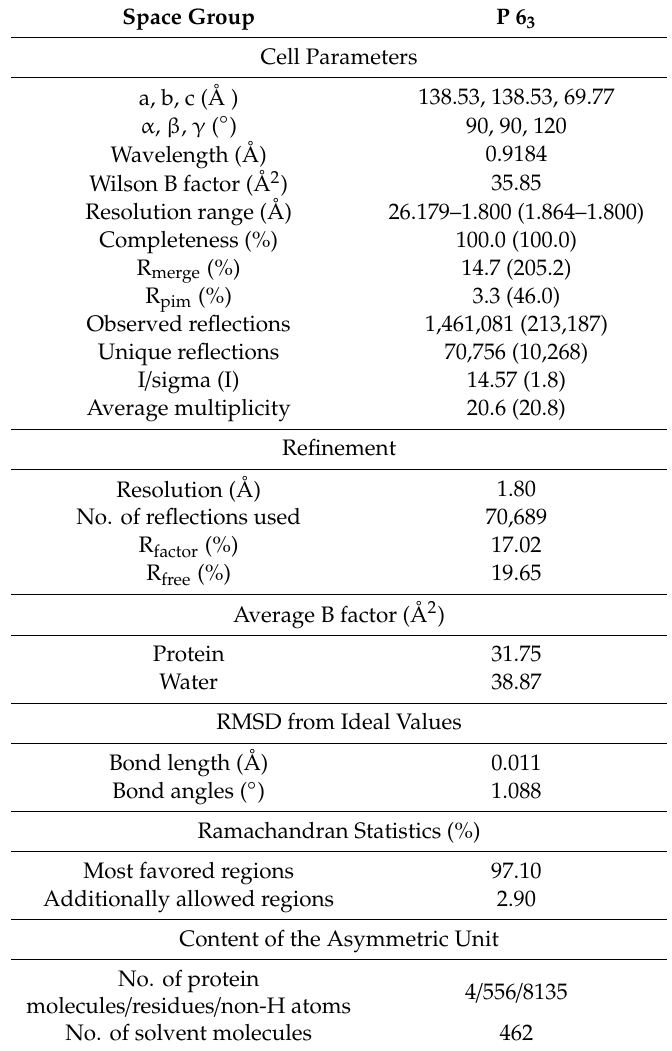
Table 1. Crystallographic Data Collection and Refinement Statistics. Data collection and